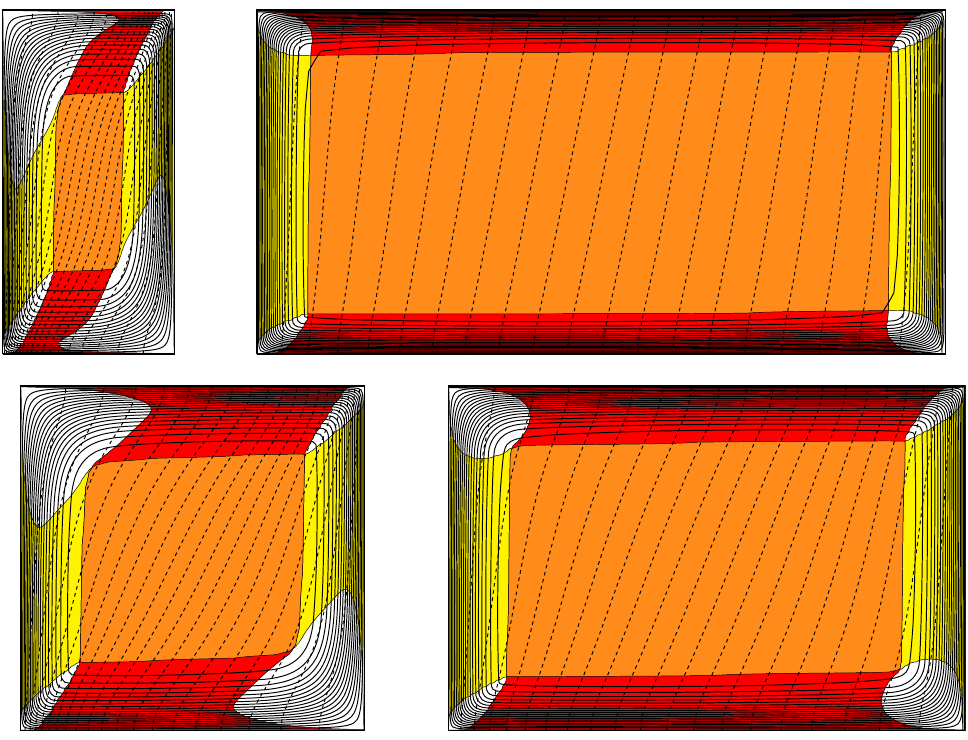
Figure 2. Streamlines (continuous) and isotherms (dashed) using a square-network-based anisotropic model and showing the effect of having different cavity aspect ratios when Ra = 100 and Rb =